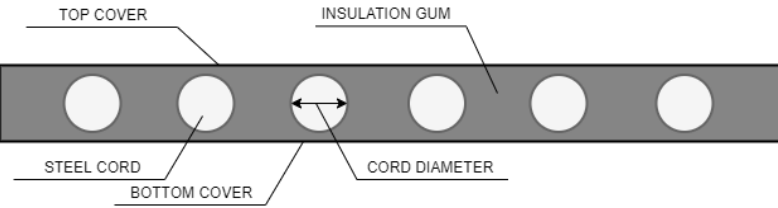
Figure 2. Diagram of the cross section through the conveyor belt.